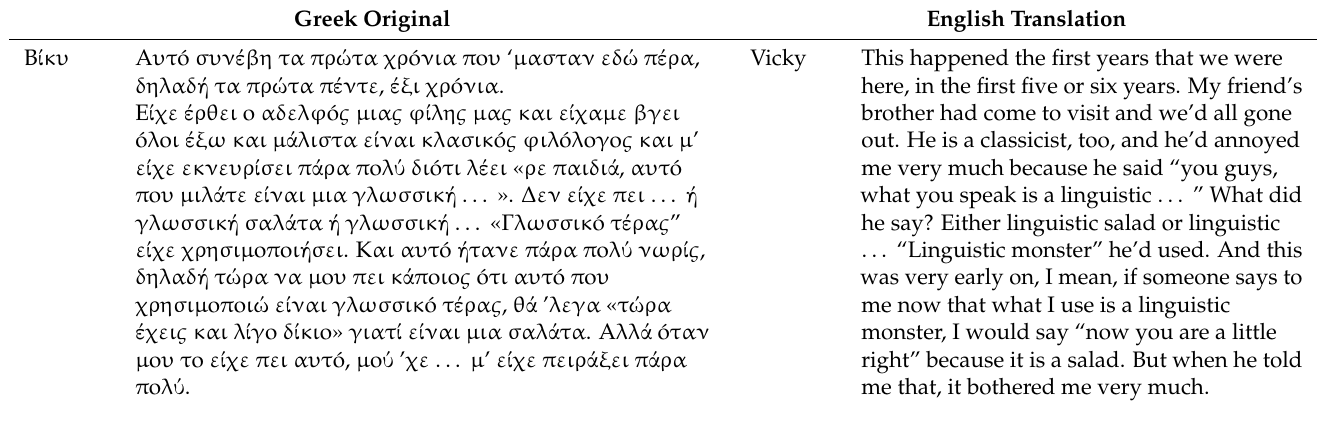
Table 4. “A linguistic